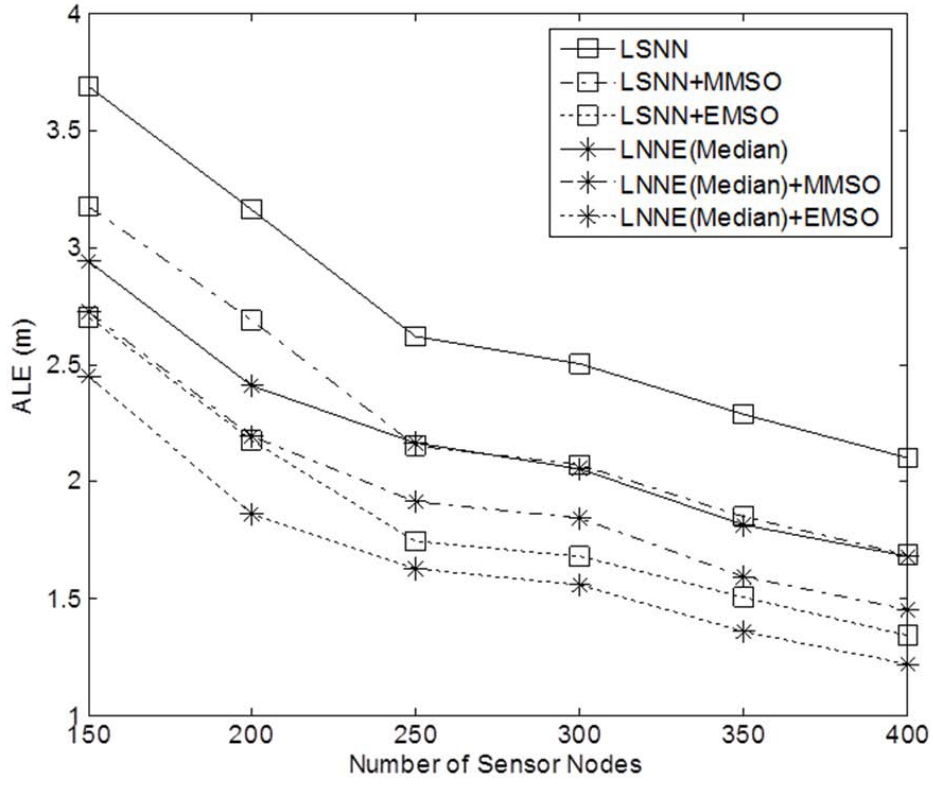
Figure 13. Performance of refinement algorithms with different network densities ( N = 150 to 400, beacon ratio = 0.2, no coverage